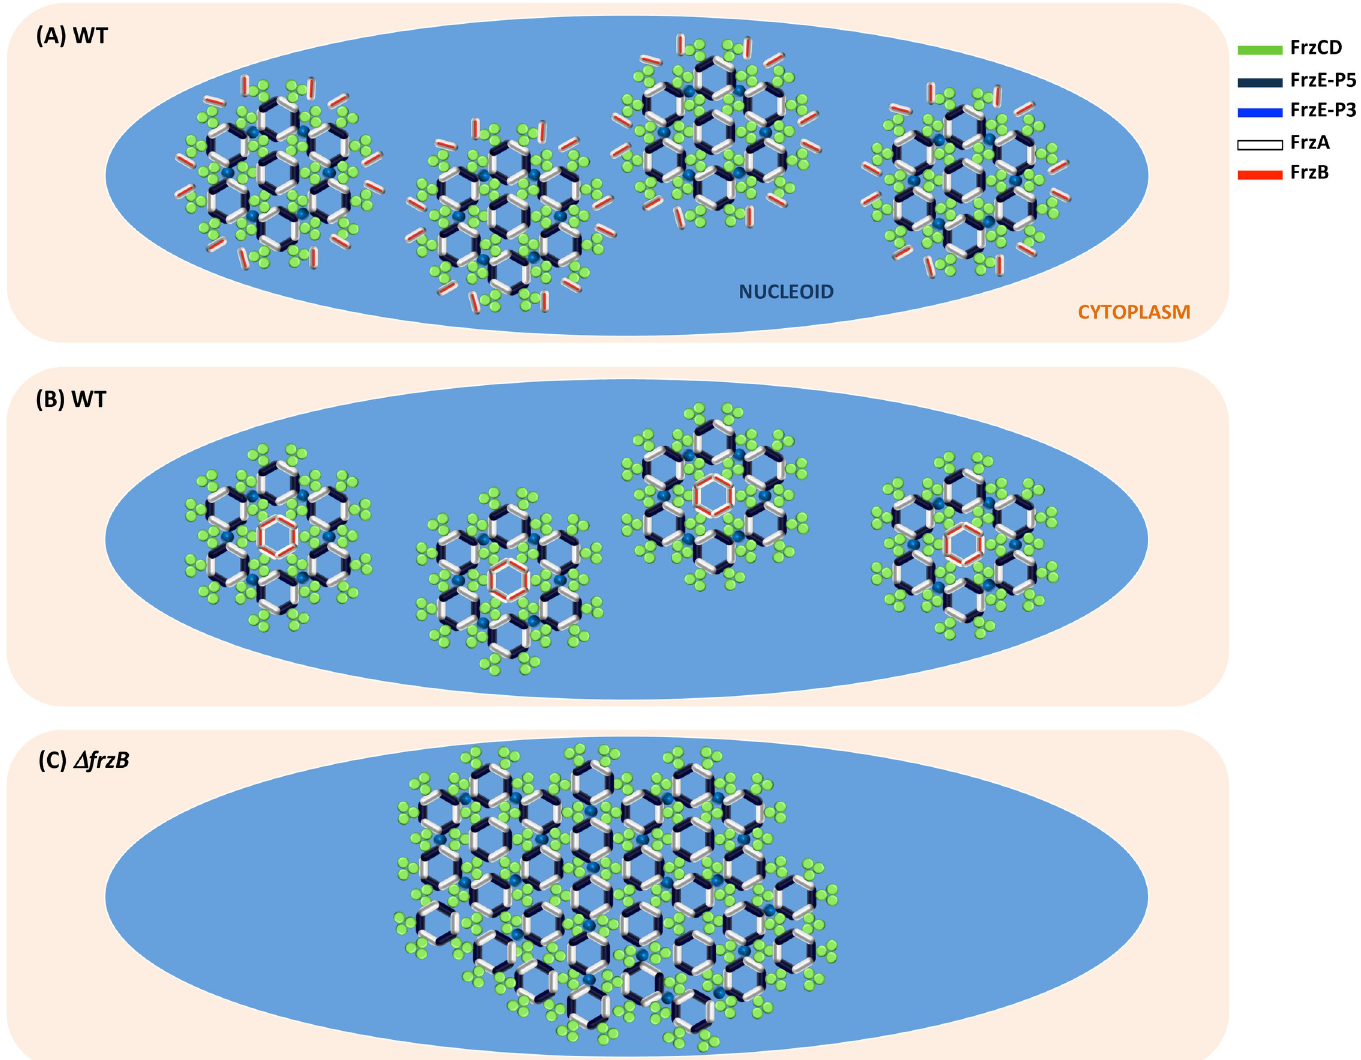
Fig 5. Proposed models on how FrzB might confer plasticity to Frz clusters. (A) FrzB participates to the formation of 6-CheW rings to stabilize small Frz clusters, which would otherwise collapse in one single cluster (C). (B) Alternatively FrzB allows the formation of small Frz clusters by breaking the networking of MCP trimers of dimers with Che P5 -CheW